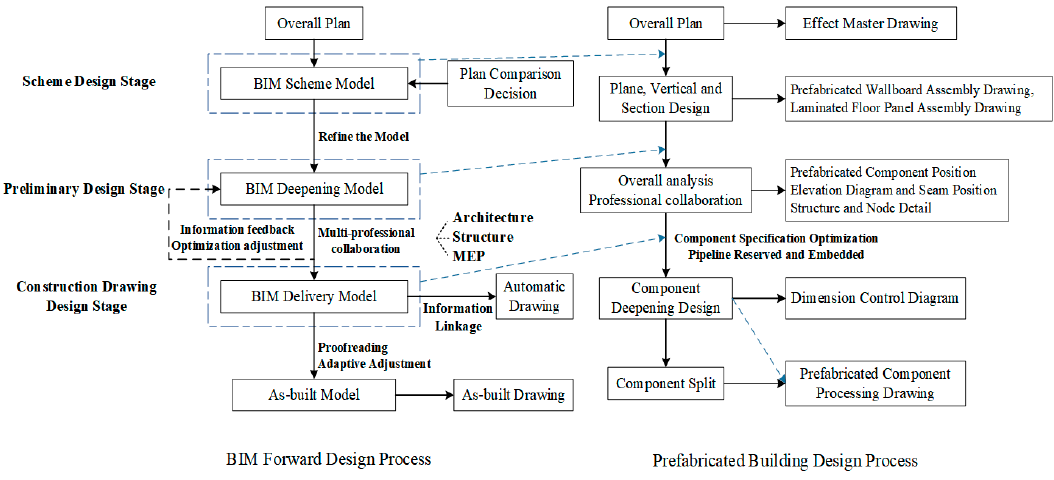
Figure 3. Forward design process of prefabricated building.